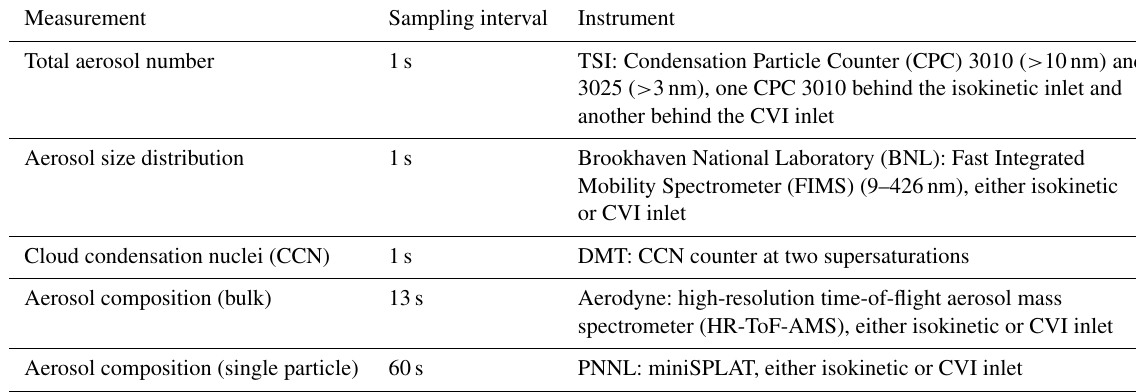
Table 1. Aerosol instrumentation deployed on the G-1 aircraft during